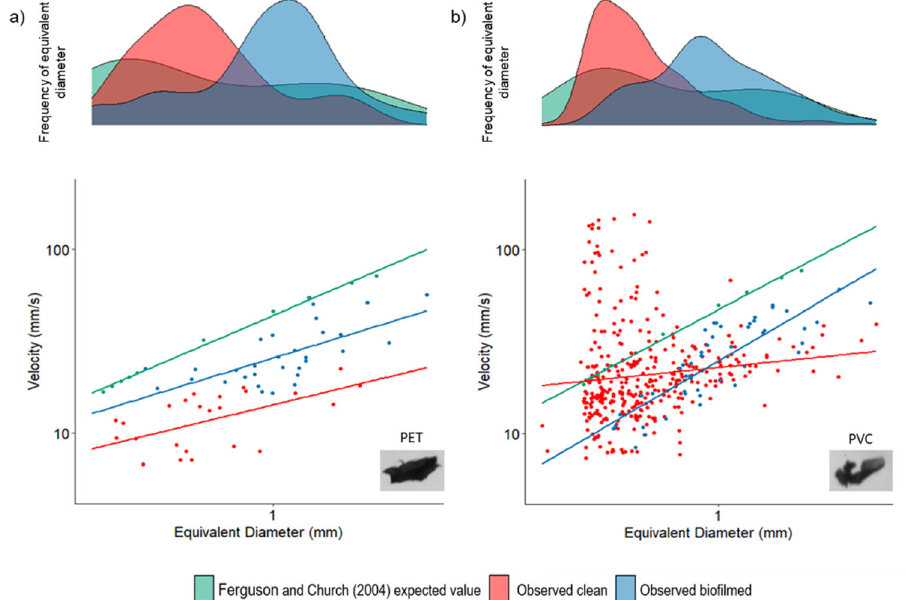
Fig. 4 Expected settling velocity calculated using Ferguson and Church compared to our observed experimental values for clean and bio fi lmed microplastics. a Polyethylene terephthalate (PET) ( n = 38) and b polyvinyl chloride (PVC) ( n = 383). The expected settling velocity of particles calculated using Ferguson and Church 37 is indicated by the green solid lines, points and shading, the observed experimental clean particle values are shown by solid red lines, points and shading and the observed experimental bio fi lmed particle values are indicated by the solid blue lines, points and shading. Marginal density plots indicate the distribution of velocity and equivalent diameter data. This highlights that grain size variation must be included in predictive